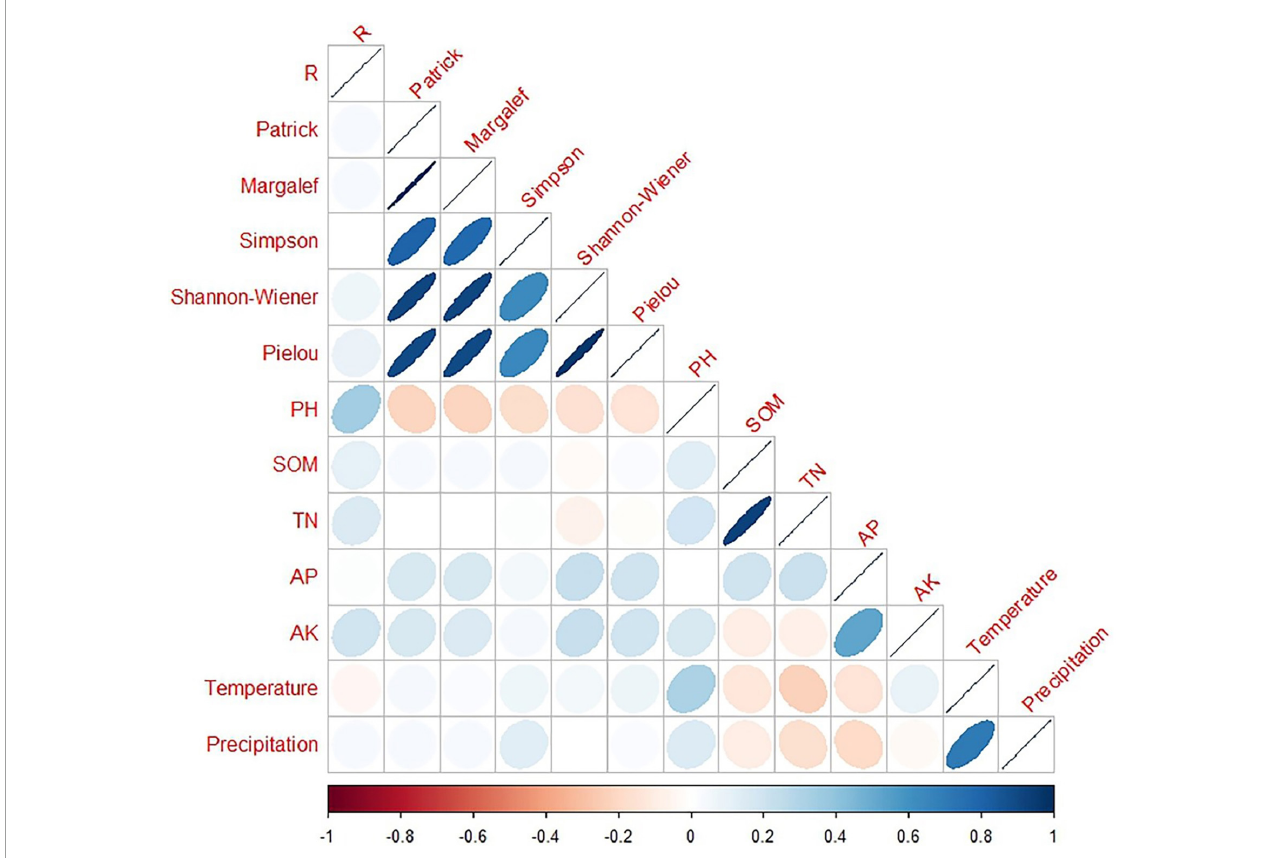
FIGURE10 Correlation matrix between R. pseudoacacia growth rate and different properties in pure stands. Blue color indicates positive correlation and red color indicates negative correlation. Precipitation (mm); Temperature ( ◦ C); pH; SOM (g/kg); TN (g/kg); AP (mg/kg); AK (mg/kg). The closer the graph is to a straight line (that is, closer to 1 or –1), the stronger the